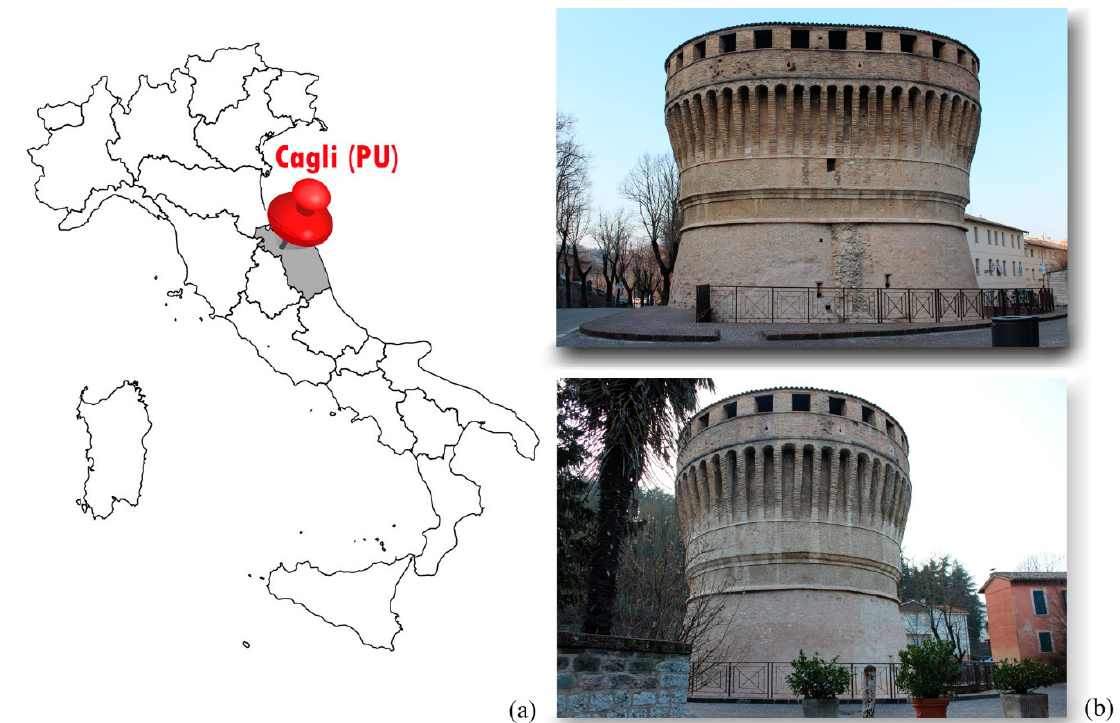
Figure 1. Geo-localization of Cagli village (Marche region, Central Italy) ( a ), and external views of the fortified tower ( b ).